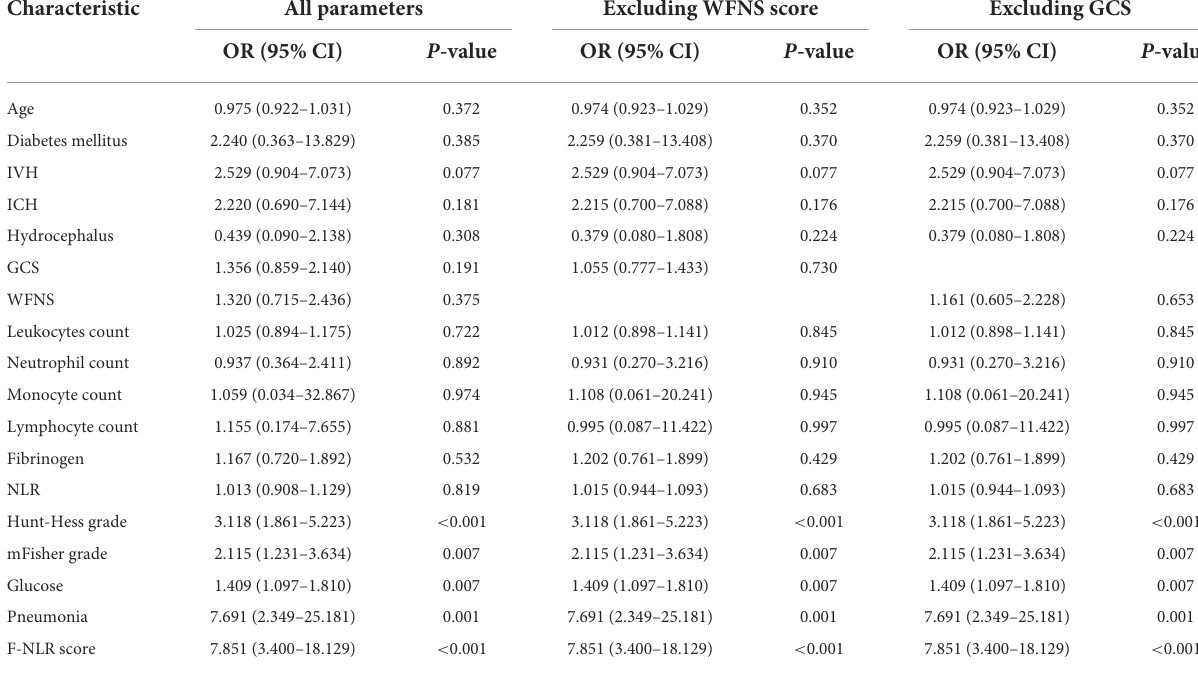
TABLE 3 Multivariable analysis of parameters associated with unfavorable outcome after